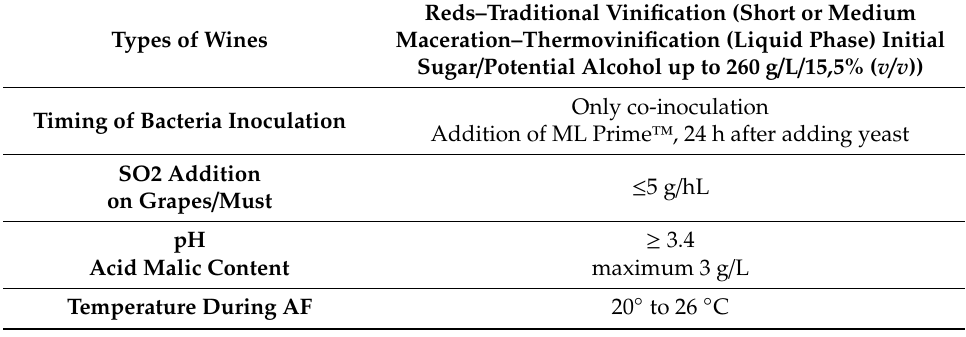
Table 2. Optimum conditions for the use of Lactobacillus plantarum ML Prime ™ .